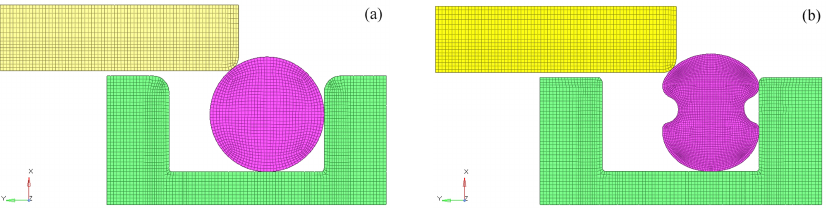
Figure 2. Finite element model. The original structure of seal is O-ring in ( a ), and the proposed structure of seal is butterfly-ring in ( b ), with the same maximum diameter as the O-ring. Both are assembled with groove in green mesh and piston rod in yellow mesh.